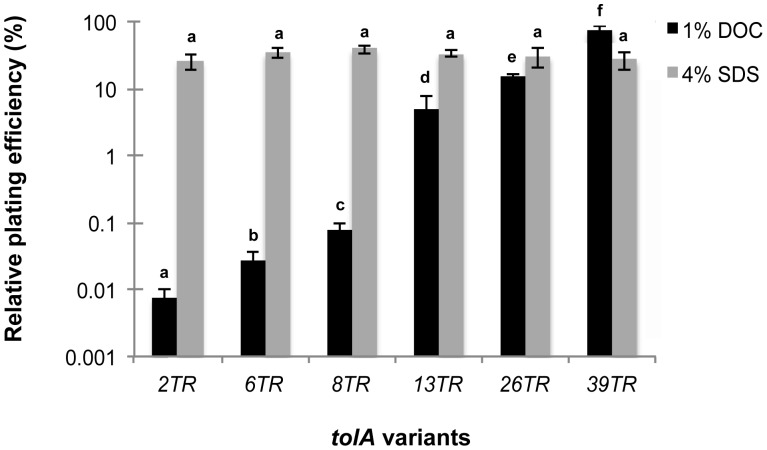
Relative plating efficiencies of MG1655 TolA TR variants on DOC 1% and SDS 4%.The relative plating efficiencies of the ΔtolA mutant were <10−5% on both media, and are not shown. 13TR refers to the reconstructed MG1655 TolA13TR strain which is identical to and produced the same results as the wild-type strain MG1655. Error bars represent standard deviations of three independent biological replicates. Bars of the same series marked with a different letter are significantly different at 0.05 level by Analysis of Variance (ANOVA) of log-transformed data followed by LSD post hoc test.